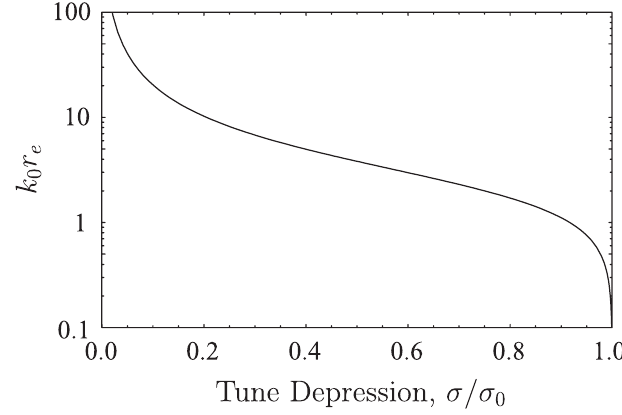
FIG. 11. Waterbag equilibrium parameter k equivalent beam tune depression (cid:3)=(cid:3) Eqs. (D13) and